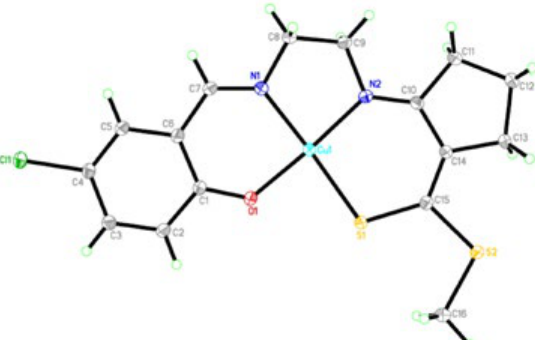
Fig.3. SEM photograph of [Cu(cd5Clsalen)] (1) nano-particles prepared by hydrothermal method